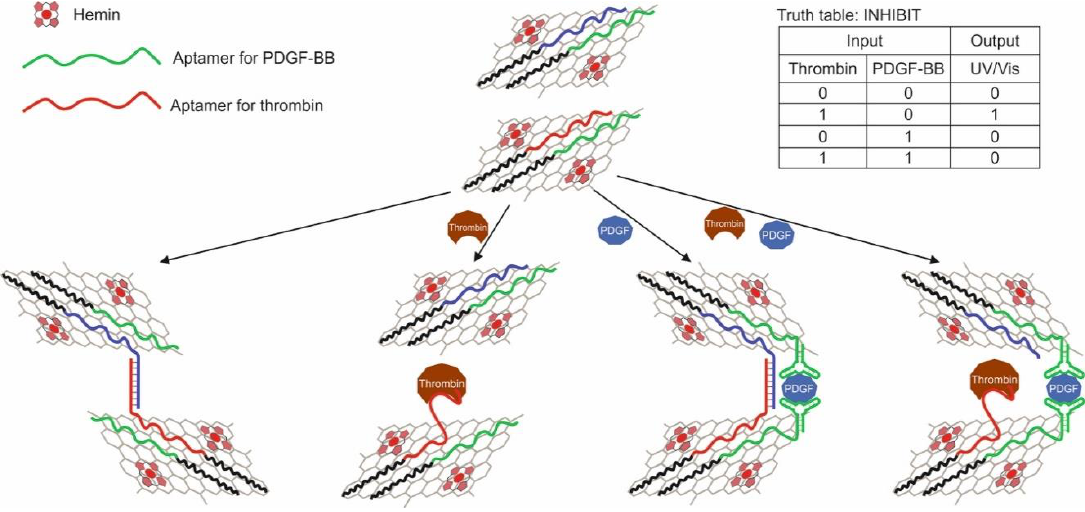
Figure 10. Logic gate INHIBIT. PDGF = platelet-derived growth factor. Adapted from Reference [70].